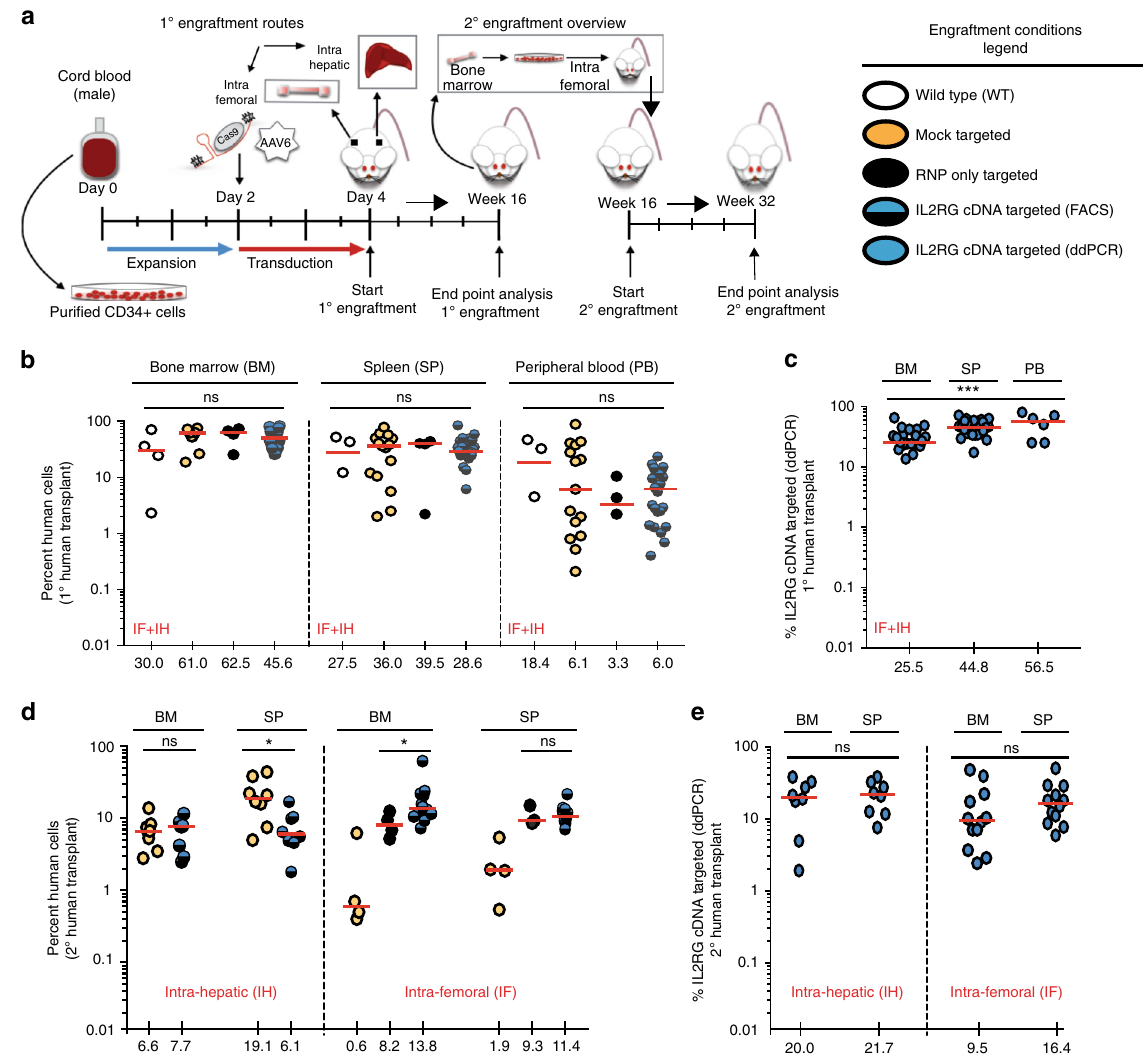
Fig. 2 Normal hematopoietic reconstitution from IL2RG cDNA targeted CD34 + HSPCs. a Timeline of primary (1°) and secondary (2°) human transplants into sub-lethally irradiated NSG mice. CD34 + HSPCs are derived from umbilical cord blood of healthy male donors. Adult mice transplanted intra-femoral (IF) with either WT CD34 + HSPCs (white circles) or mock targeted (yellow circles) or RNP only (black circles) or un-selected IL2RG cDNA targeted (blue- black circles) HSPCs. Three – 4 days old NSG pups transplanted intra-hepatic (IH) with either mock or IL2RG targeted HSPCs. b Combined IF and IH human cells engraftment (hCD45 + HLA A-B-C + ) 16 weeks after 1° human transplant into indicated organs. c % IL2RG cDNA targeted HSPCs within human graft in indicated organs, quanti fi ed by ddPCR. BM ( n = 24 mice), SP ( n = 24 mice), PB ( n = 6 mice) (*** p = 0.0008, one-way ANOVA). d Percent human engraftment in indicated organs as in ( b ) 16 weeks post 2° human CD34 + HSPCs transplant into adult NSG mice. * p -value SP-IH = 0.025, * p -value BM-IF = 0.043 (Welch ’ s t -test). e % IL2RG targeted HSPCs quantied by ddPCR 32 weeks after engraftment. Median shown. BM bone marrow, SP spleen,